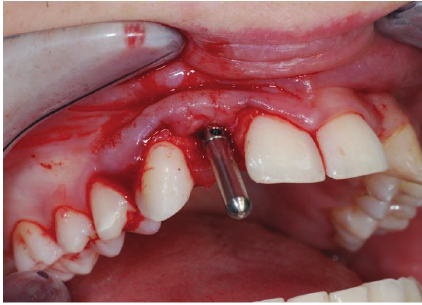
Figure 9: Clinical examination of the correct inclination.